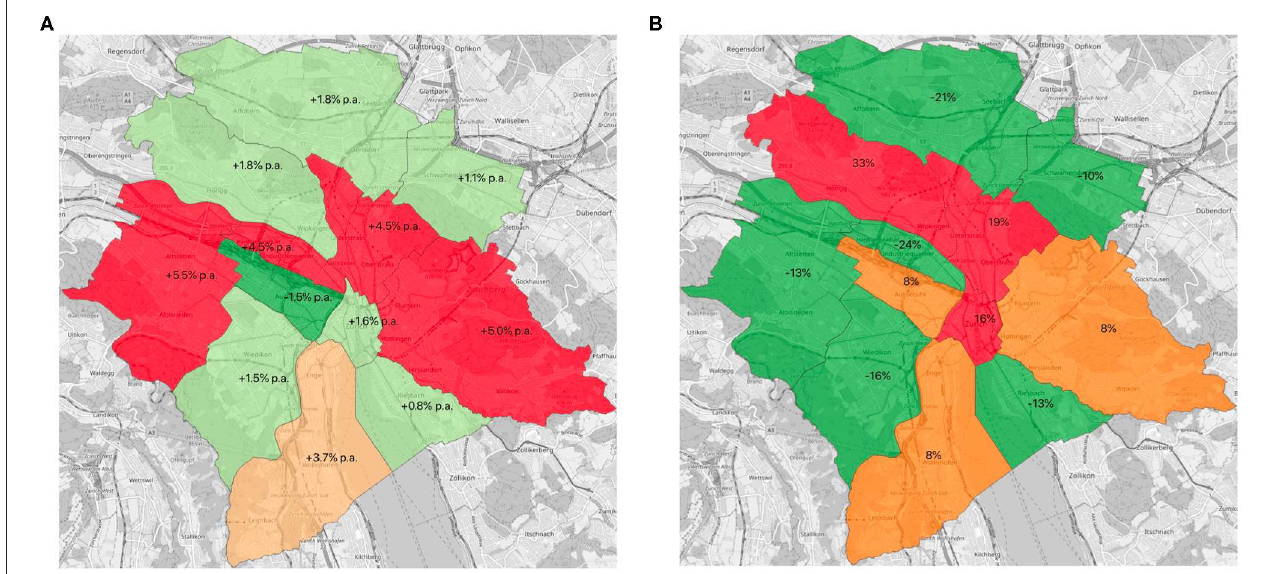
FIGURE 4 | GIS-based display of results; (A) : Accident trend, (B) : Difference of predicted and actual